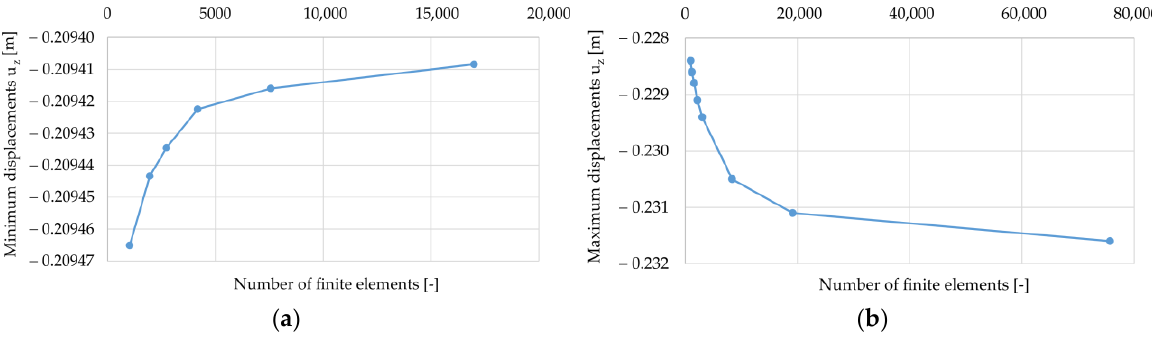
Figure 4. Minimum vertical displacements u z at half the distance between columns depending on the number of elements: ( a ) variant B1; ( b ) variant B2.